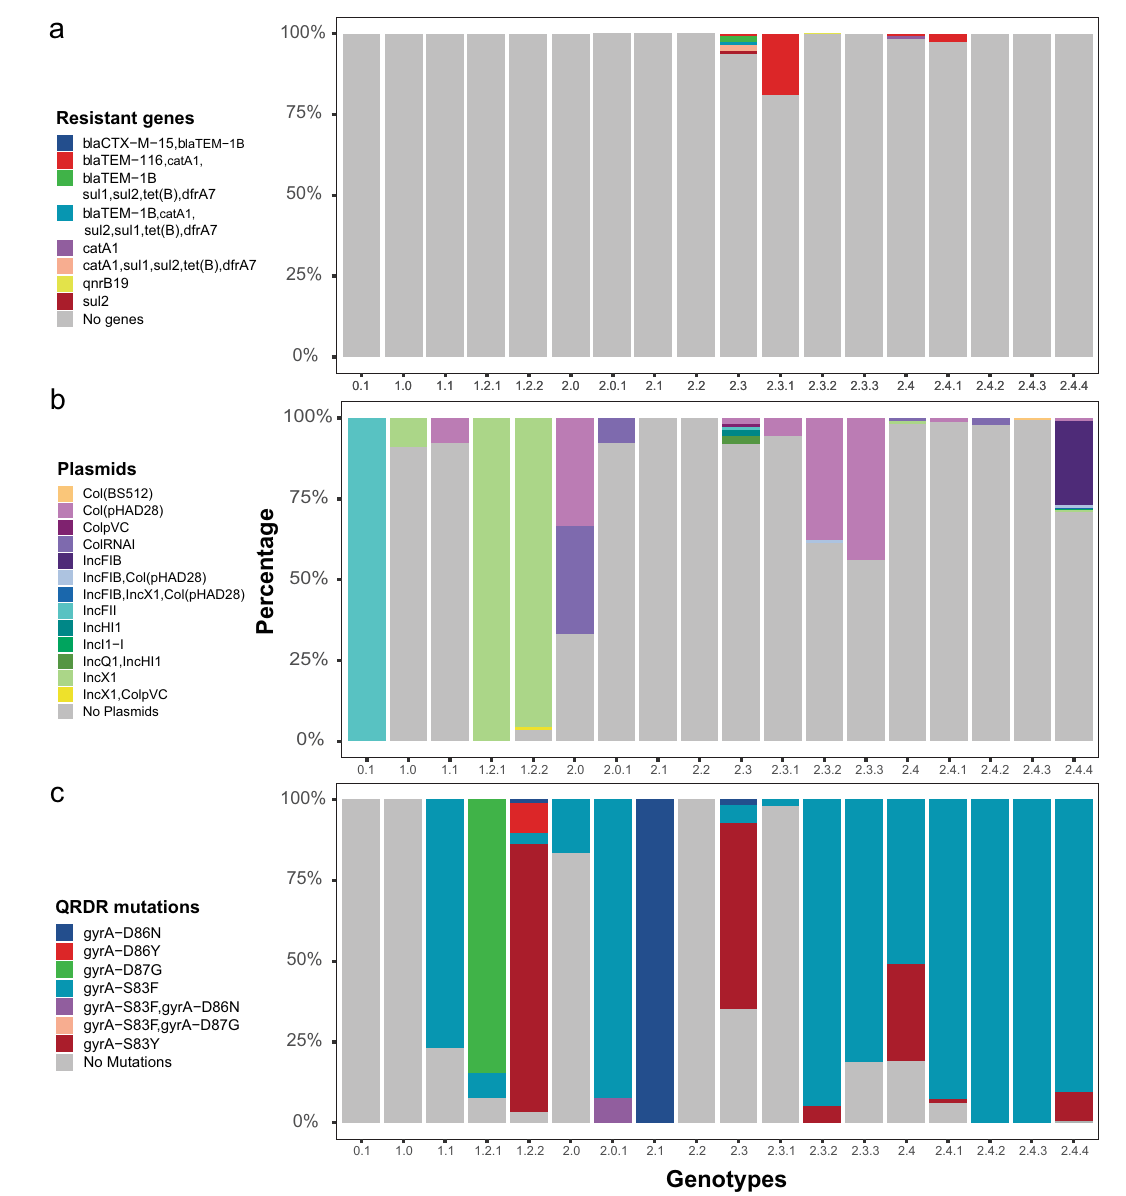
Fig.4|Presenceofantimicrobialresistancegenes,plasmids,andchromosomal mutations linked to quinolone resistance across different Salmonella Para- typhiAgenotypes. Thediversityof( a )Antimicrobialresistancegenes( b )Plasmids